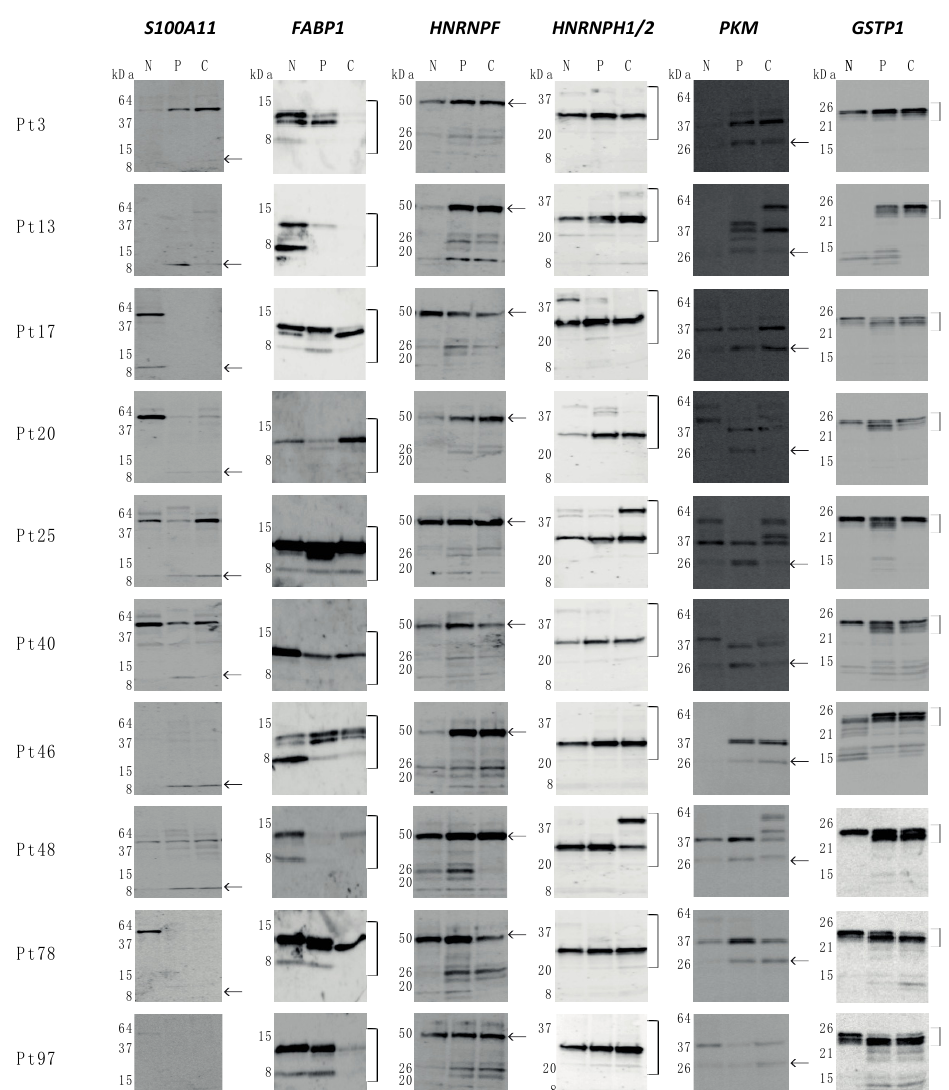
Figure 2. Western blotting of tissues from CRC patients from non-involved part of the colorectal tissue (N), peripheral part of tumor (P) and central part of tumor (C). Antibodies against S100A11 , FABP1 , HNRNPF , HNRNPH1/2 , PKM , and GSTP1 were incubated with the blots. Total pixel intensity was measured in the bands as indicated to the right of the blots. The value of the bands in N was set to 1 and the P and C samples were calculated relative to the N value and log 2 -transformed as given in Figure 3.